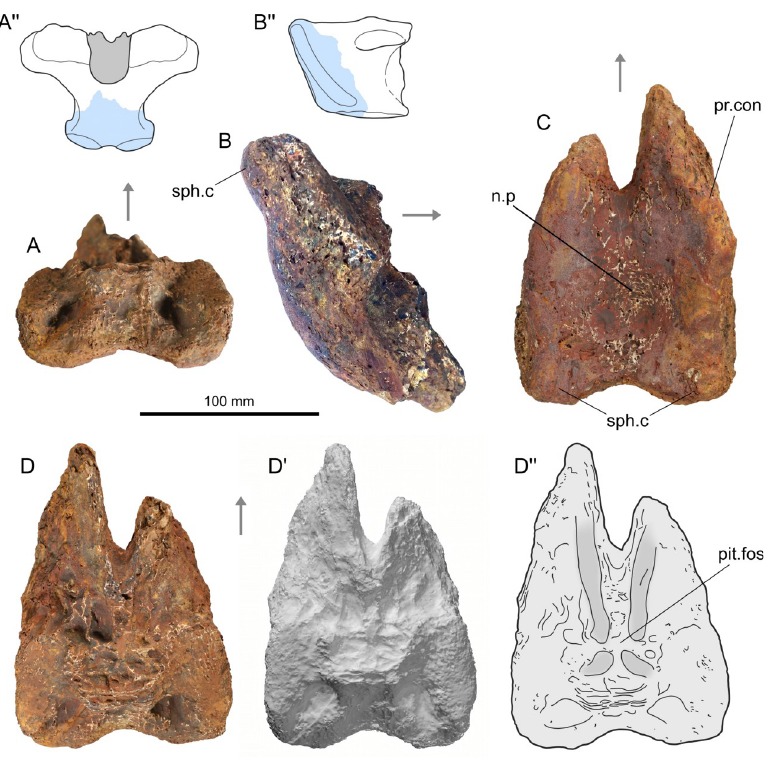
Fig 5. Photographs, surface rendering (apostrophe) and schematic drawings (double apostrophes) of a posterior portion of basisphenoid (SMU 77728) of Mawsonia sp. from the Woodbine Formation, in dorsal (A), right lateral (B), posteroventral (C) and anterodorsal (D) views (A’ and B’, redrawn from Wenz, 1981). Abbreviations: n.p, notochordal pit; pit.fos, pituitary fossa; pr.con, processus connectens; sph.c, sphenoid condyles. The arrows indicate the anterior